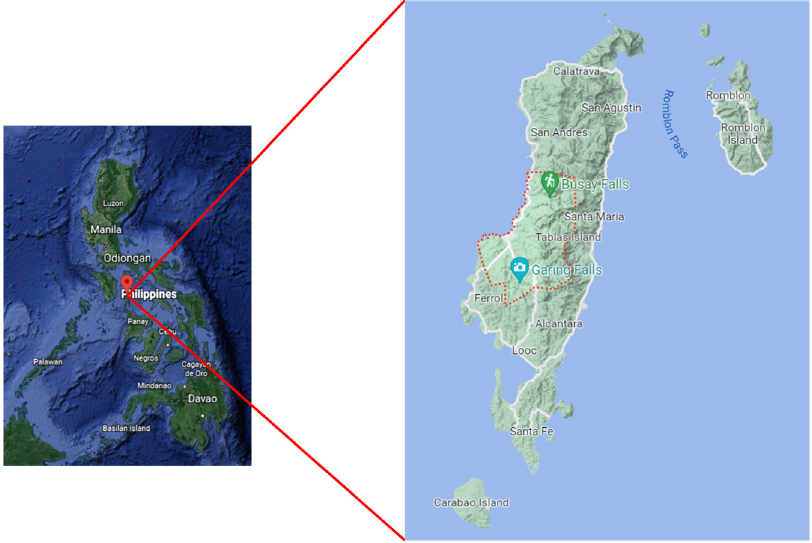
Figure 1. Location of the study area, Odiongan, Romblon, Philippines (12°24 ′ 4.88 ″ N, 121°59 ′ 2.17 ″